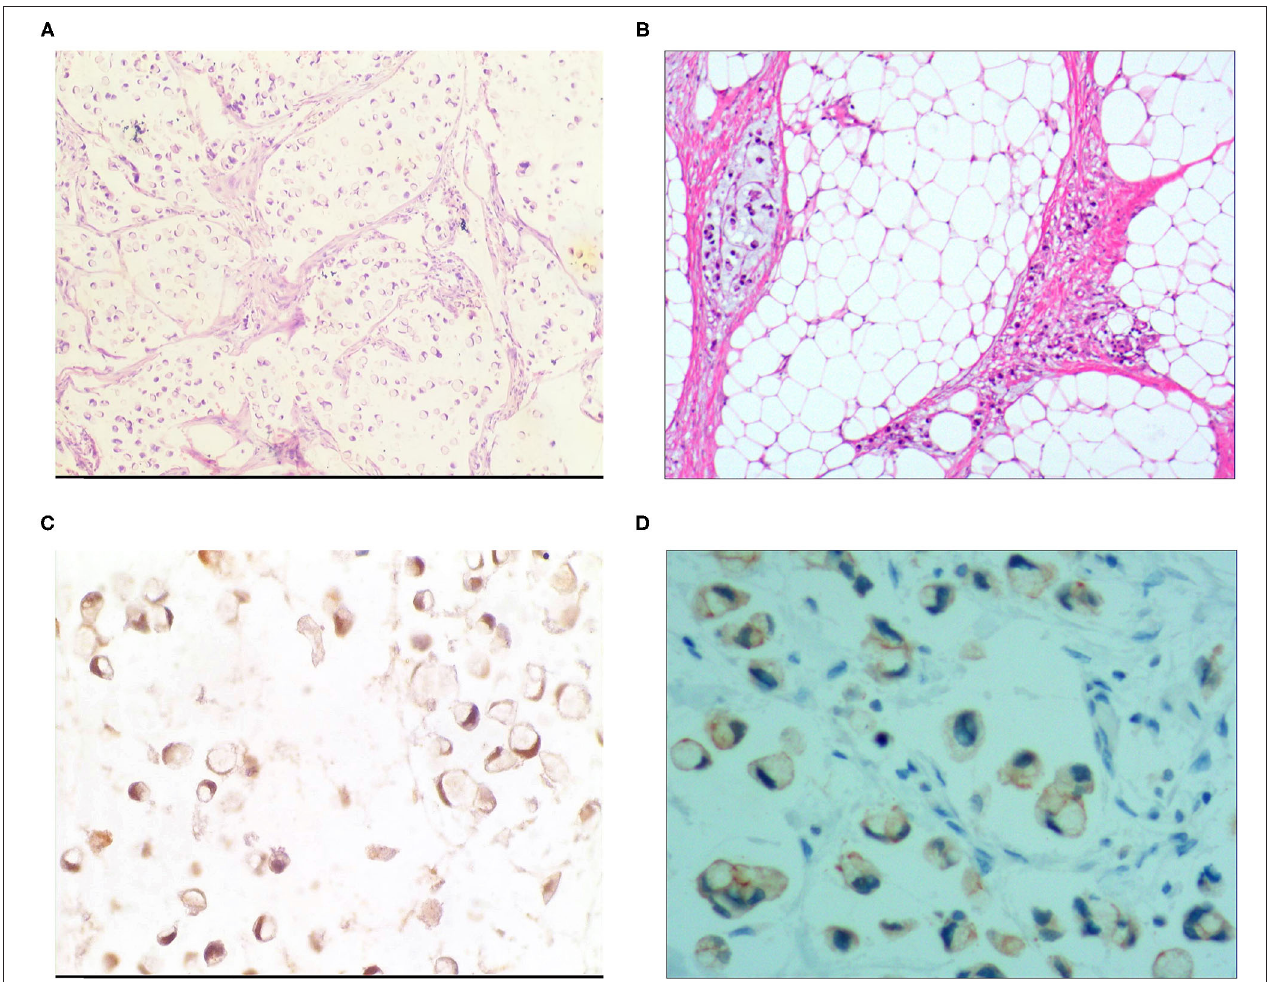
FIGURE 3 | Signet ring cell type mucinous carcinoma. (A) It was composed of signet ring cell carcinoma cells and mucinous tissues. The cells accounted for 20-80% of the tumor; H&E, × 100. (B) The tumor’s primary invasion feature was to grow diffusely, jumpily, and invasively and then invade the spaces among the surrounding tissues, lymphatic vessels, and blood vessels to destroy the tissues; H&E, × 100. (C) CKpan was positively expressed in the cancer cells; EnVision method TM , × 400. (D) DX2 was positively expressed; EnVision method TM , ×